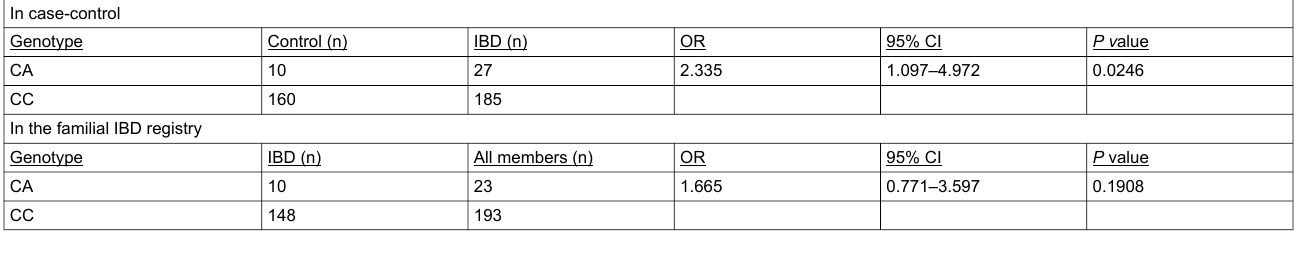
Table 1: Association of DLG5 P1371Q with IBD in familial and sporadic IBD. In case-control